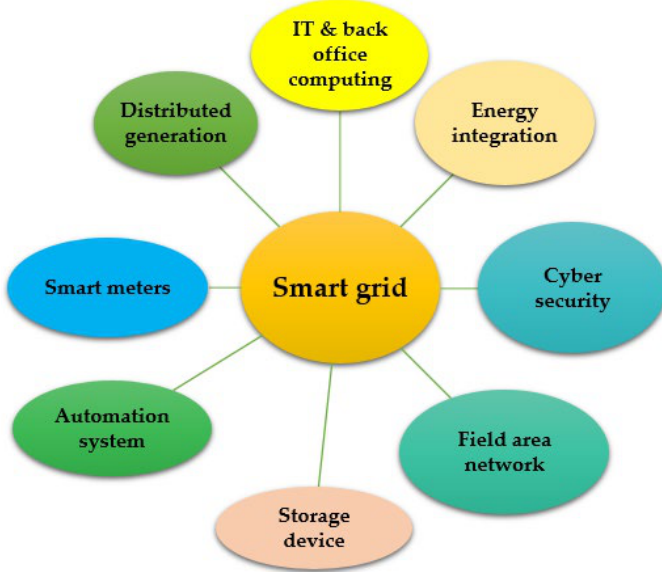
Figure 3. Essential components of the Smart grid [29].